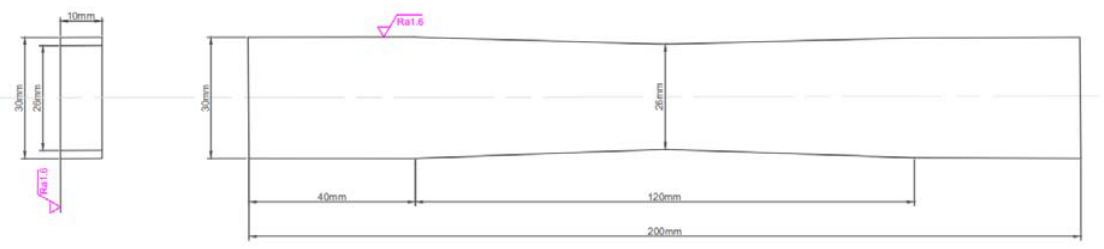
Figure 5. Test specimens.